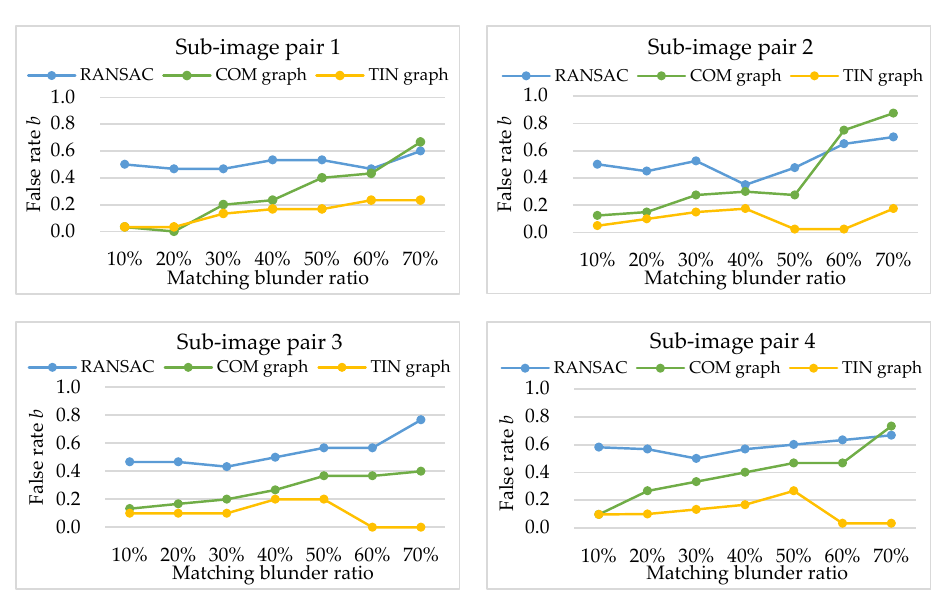
Figure 7. Experimental results of false rate b .